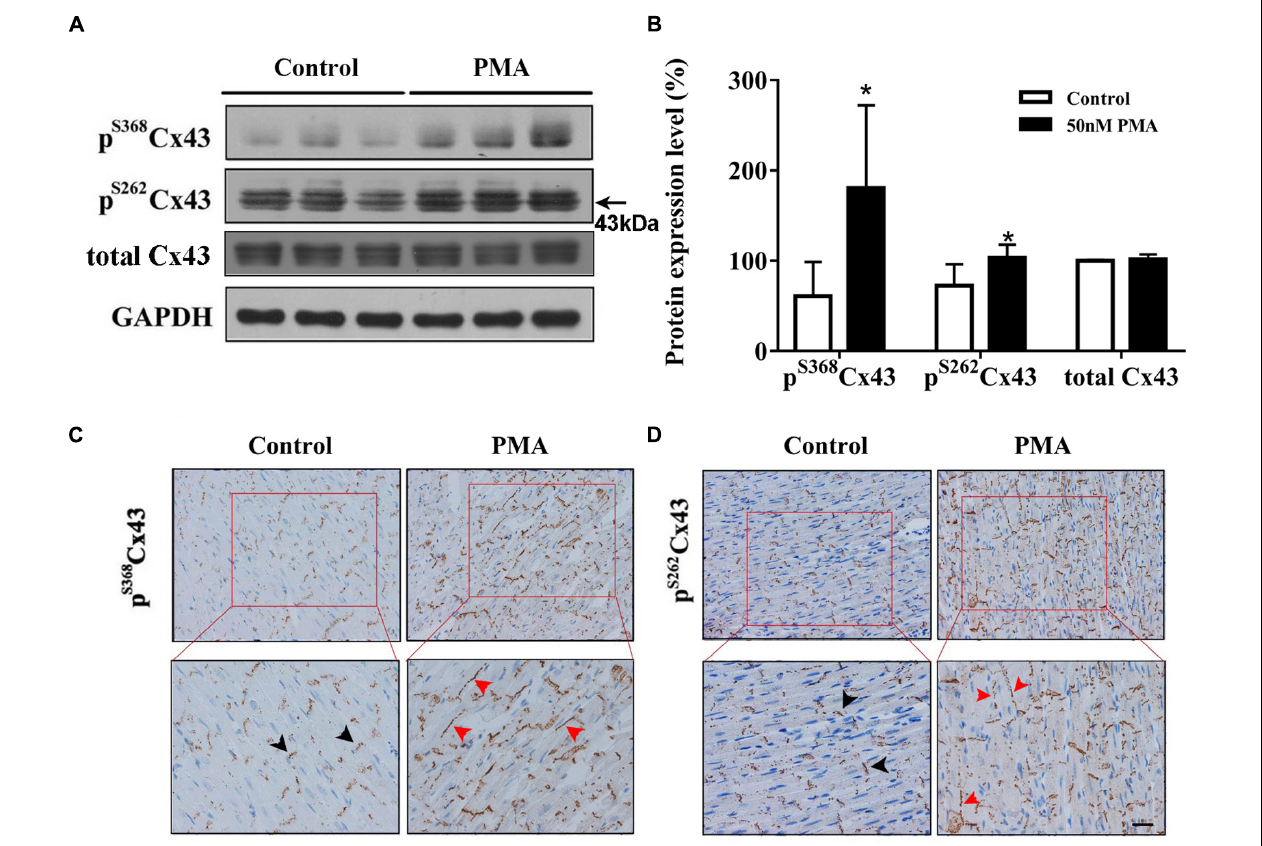
FIGURE 2 | Short-time PMA perfusion increased phosphorylation of Cx43 at serine 368 and serine 262 and its redistribution in isolated hearts. (A) Western blot images showing pS368Cx43 and pS262Cx43 levels were increased after PMA perfusion (30 min). (B) Corresponding statistical data. (C,D) Immunohistochemical analysis of pS368Cx43 and pS262Cx43 expression and redistribution (Bar = 20 µ m). The black arrows indicate normal Cx43 in the intercalated disc, and red arrows indicate Cx43 lateralization after PMA perfusion. Error bars represent mean ± SD , n = 3 for each group. * p < 0.05 vs. control (KH